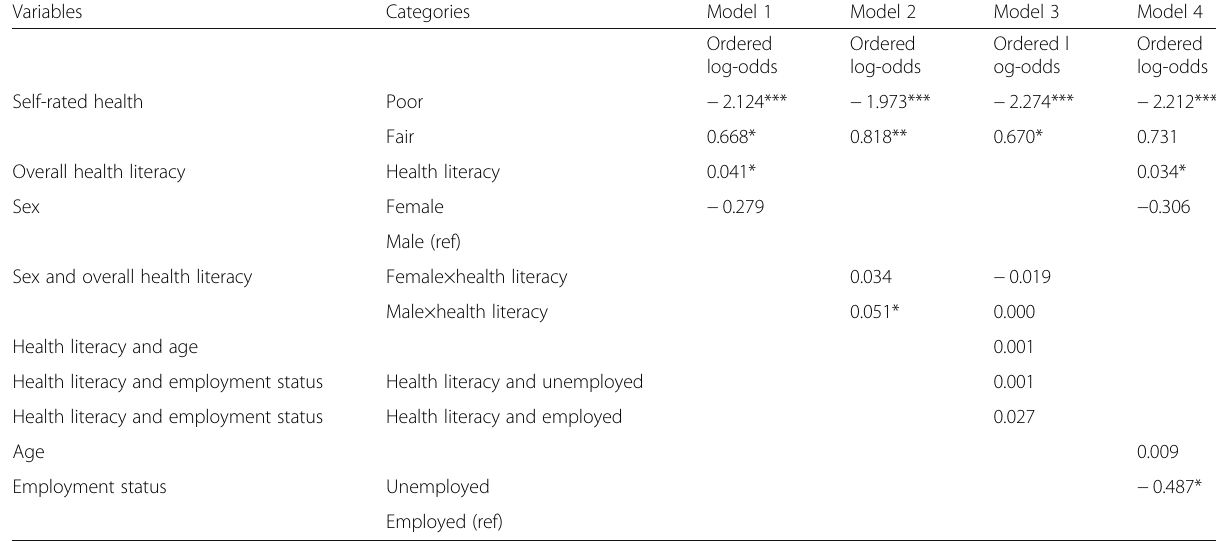
Table 3 Ordinal logistic regression of self-rated health